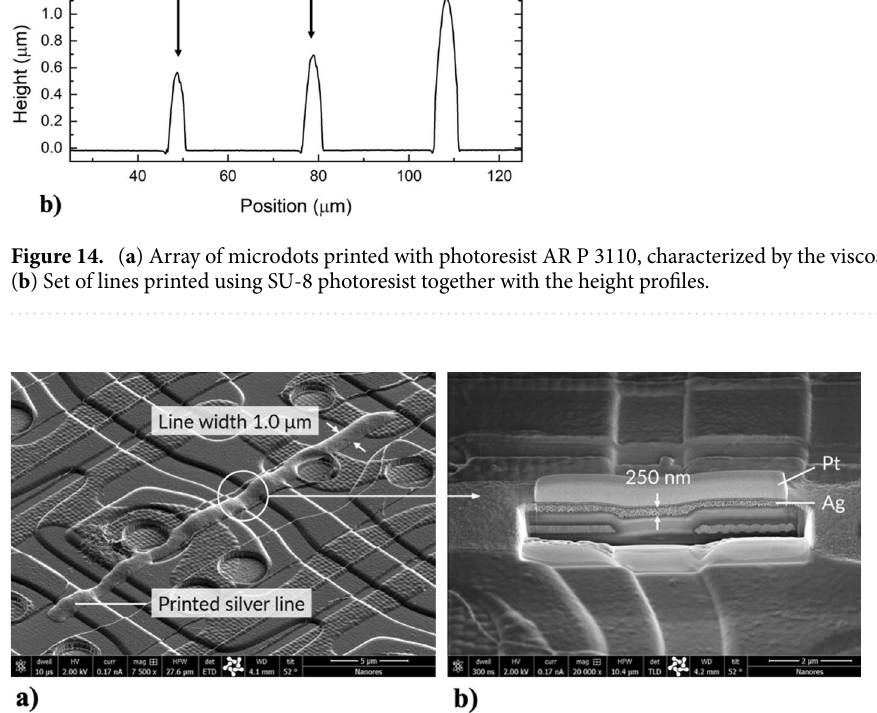
Figure 15. ( a ) Silver line with a width of 1 µm and length of 20 µm printed on an OLED substrate; ( b ) cross section of the line. Platinum layer is for imaging